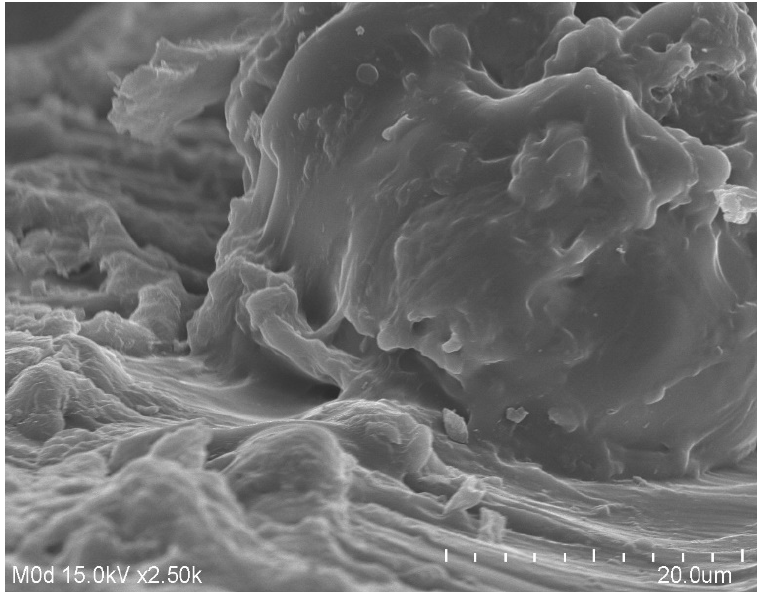
Figure 6. SEM of CS/Al-g-pAa hydrogel.